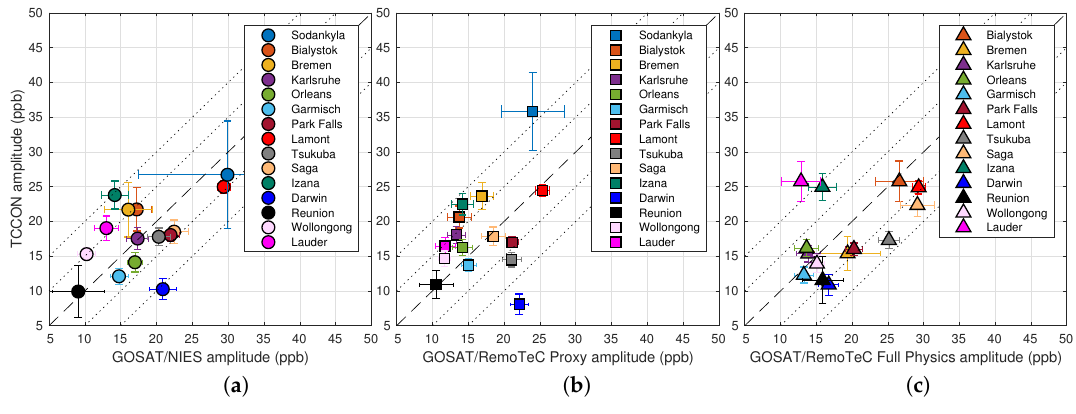
Figure 9. XCH 4 seasonal cycle peak-to-peak amplitude: ( a ) for NIES; ( b ) for RemoTeC Proxy; and ( c ) for RemoTeC FP, at all 15 TCCON sites studied. The amplitude for co-located TCCON retrievals is on the vertical axis. The dashed lines correspond to the one-to-one line and dotted lines correspond to ± 5 and ± 10